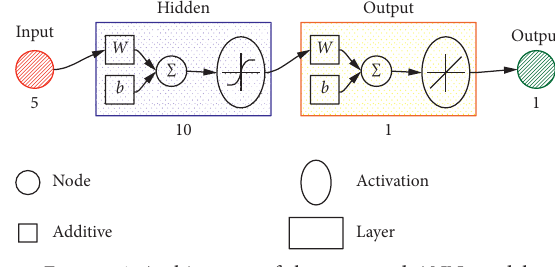
Figure 6: Architecture of the proposed ANN model. Table 5: Weight matrix and bias vector of the hidden layer.